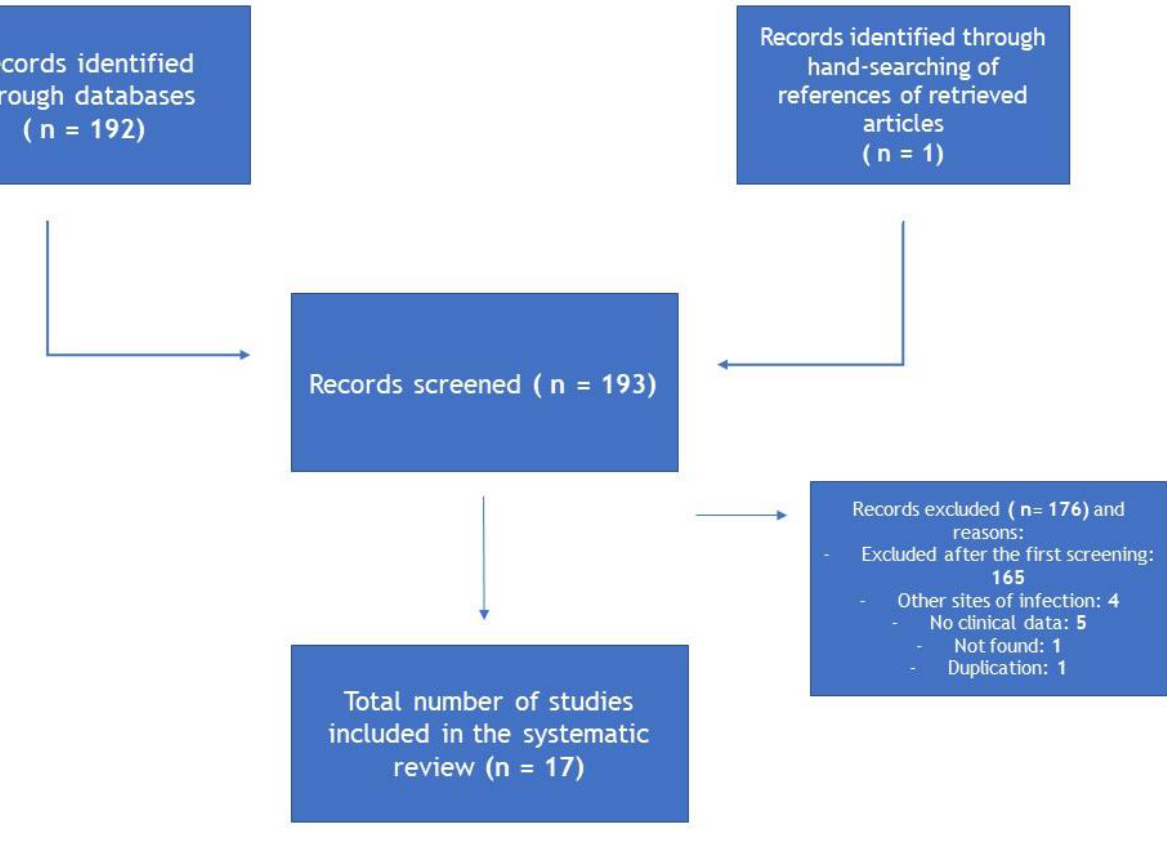
Figure 2. Literature search strategy.